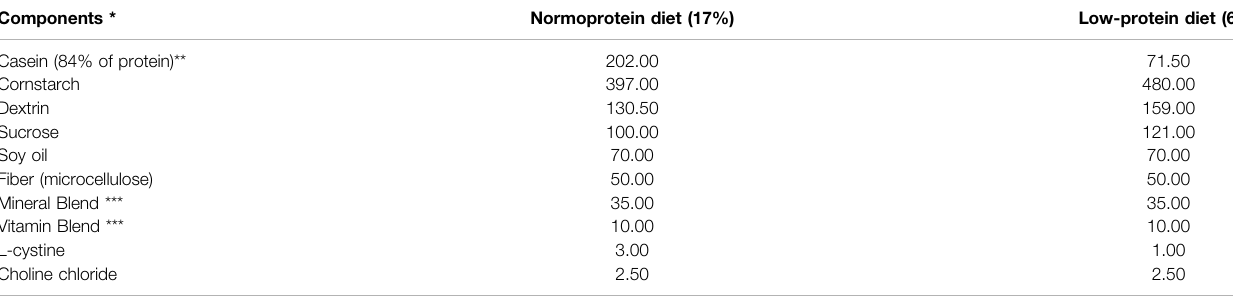
TABLE 1 | Composition of diets offered to animals during gestation and